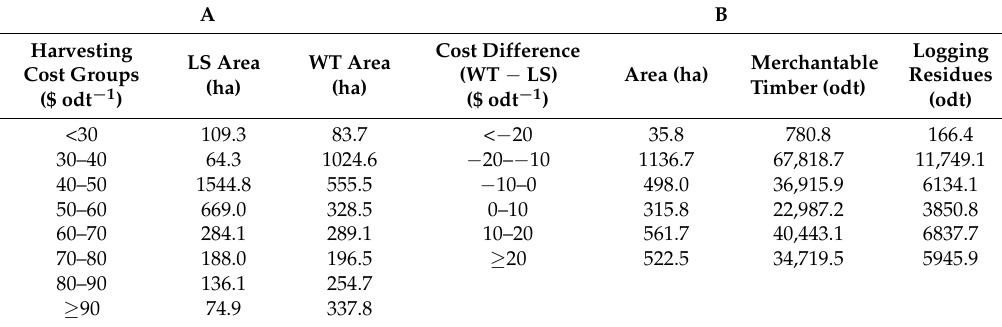
Table 9. ( A ) Lodgepole pine stand areas of the Colorado State Forest State Park assigned to whole-tree harvesting (WT) and lop and scatter (LS) methods based on harvesting costs. ( B ) The area, merchantable timber, and logging residues in each cost difference group between the two harvesting methods (WT −